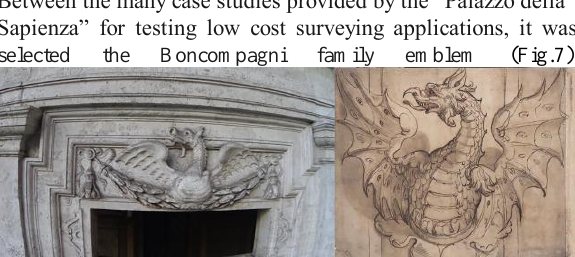
Figure 7. The Boncompagni heraldic emblem on lintel; a dragon with scaly outstretched wings designed for the Pope Gregorio XIII from B. Passerotti in 1572 (orig.